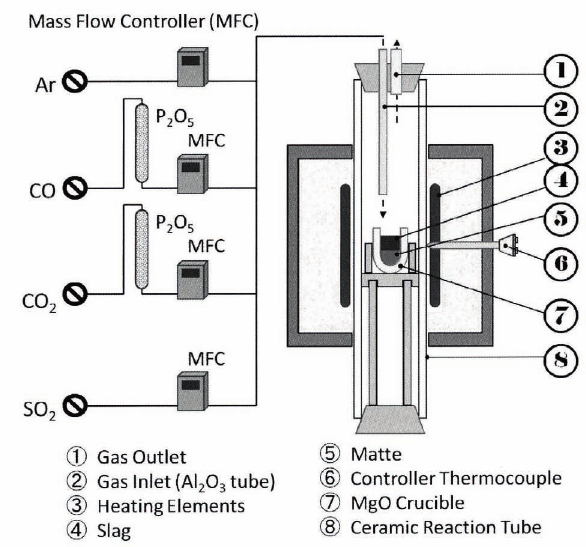
Figure 3. Experimental